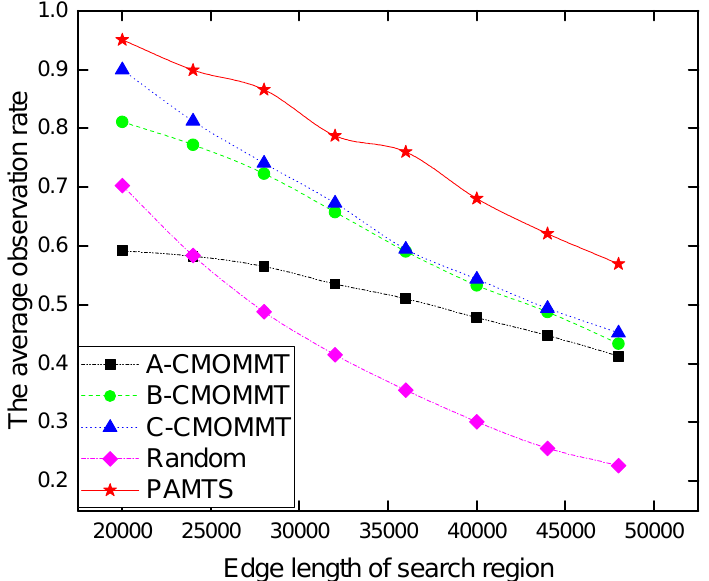
Figure 7. The impact of various size of search region on search performance under the condition of N / M = 20/40 and SR = 2600